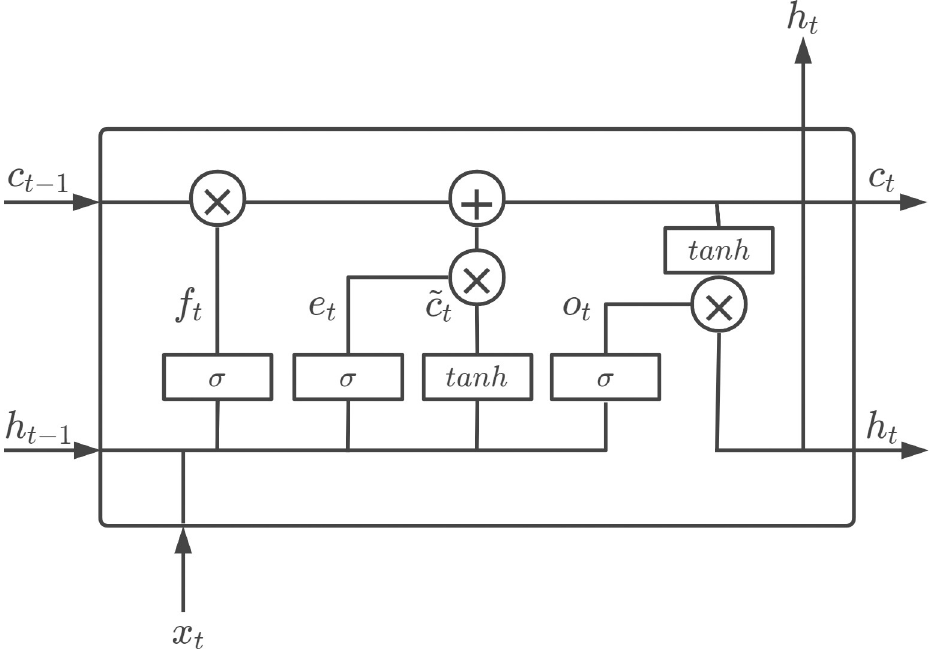
Fig 2. LSTM network